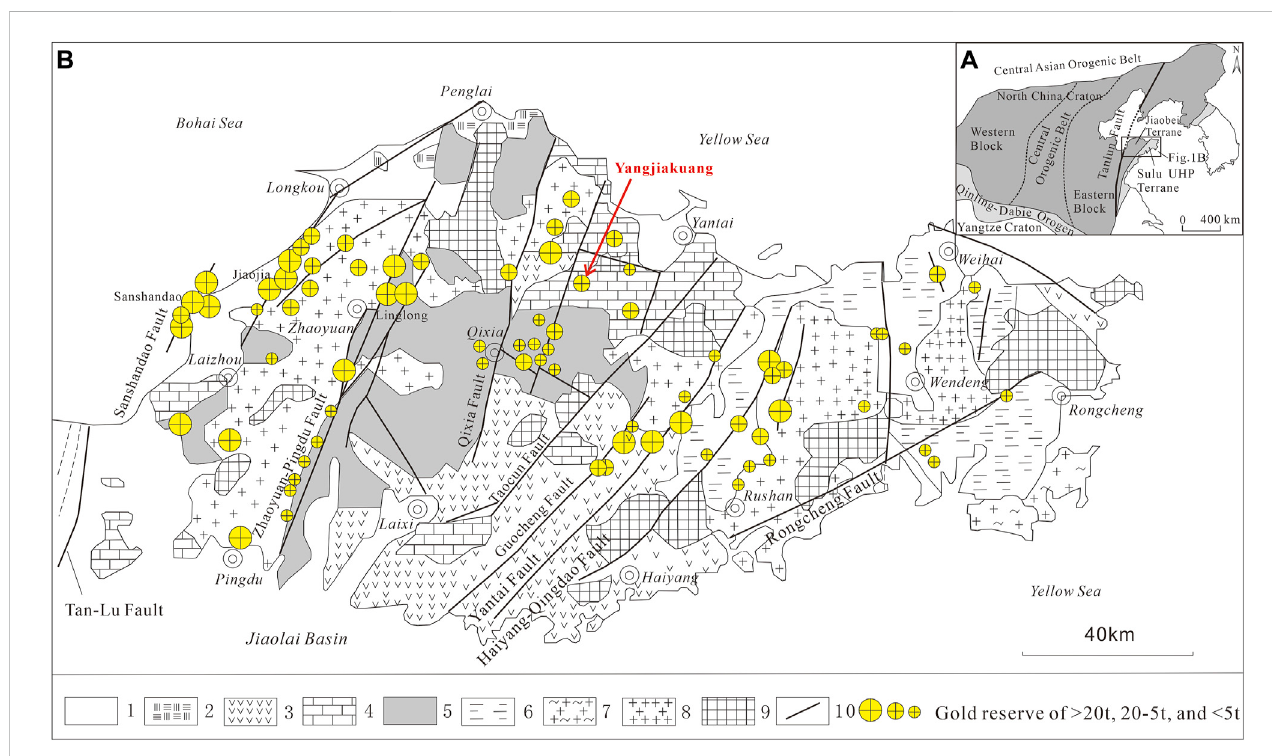
FIGURE 1 Simpli fi ed geological map of the Jiaodong Peninsula, showing the distribution of gold deposits, strata, magmatic rocks, and main faults (B) . Inset shows tectonic blocksoftheNorth China Craton andthelocation of theJiaodong Peninsula (A) (simpli fi edfromDinget al.,2015;Lietal., 2020;Dangetal., 2022).1. Cenozoic sedimentary rocks; 2. Cenozoic basalts; 3. Cretaceous volcanic rocks; 4. Paleoproterozoic Jingshan Group and Fenzishan Group metamorphic rocks; 5. Neoarchean TTG and metamorphic supracrustal rocks; 6. Proterozoic granitic complex rocks; 7. Triassic granites; 8. Jurassic granites; 9. Cretaceous granites; 10. Regional